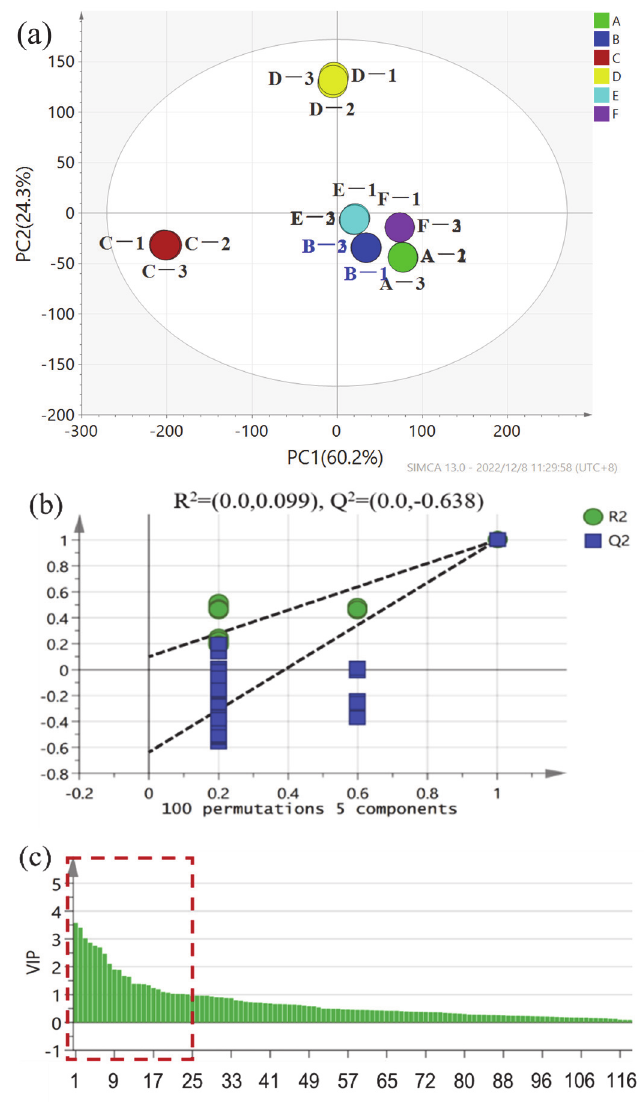
Figure 4. Schemes follow the same formatting. PLS-DA analysis based on volatile compounds. ( a ) Scores, ( b ) permutation test, and ( c ) VIP plot constructed by adopting the concentrations of strong-flavor daqu’s volatile compounds. The consecutive numbers of the horizontal coordinates in ( c ) correspond to the different compounds, as shown in Table S2, the red boxed line indicates substances with VIP > 1. A, B, C, D, E, and F represent samples from different periods,